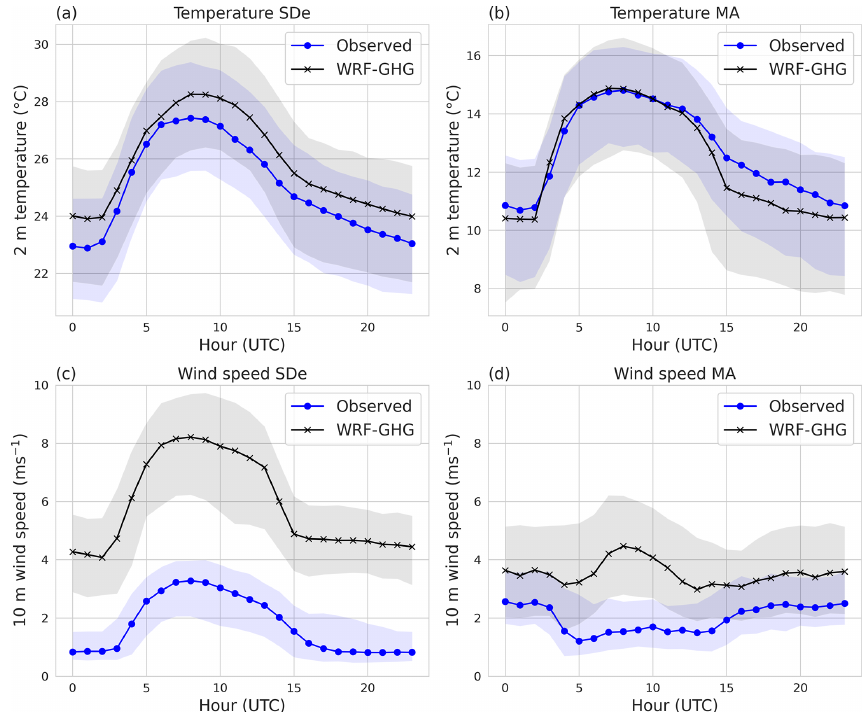
Figure 3. (a–b) Diurnal cycle of the 2m temperature and (c–d) 10m wind speed at both SDe and MA. The blue and black lines show the median values for every hour of the measurements and simulations, respectively. The shaded blue and gray areas indicate the corresponding interquartile ranges of the measurements and simulations, respectively. Hours are given in UTC (local time at Réunion Island is UTC + 4). Note that the temperature plots have different y